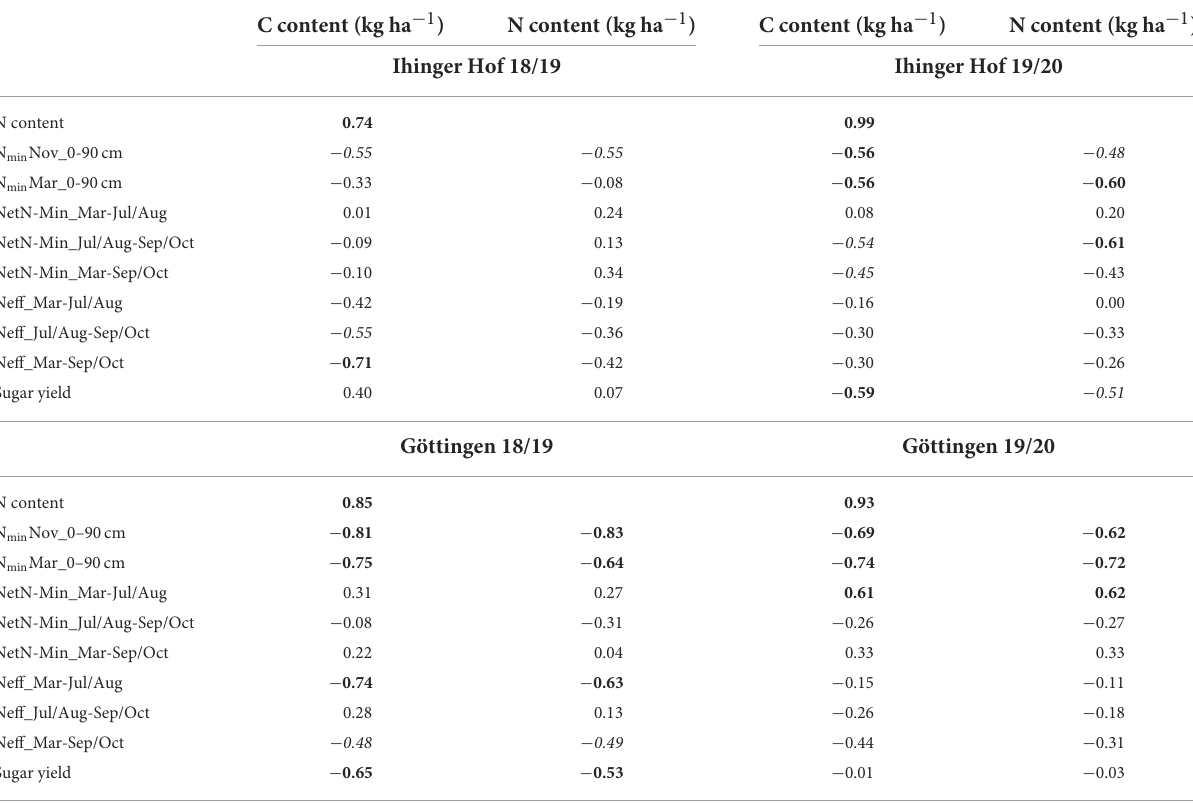
TABLE 4 Pearson correlation coefficients for the correlation among cover crop C and N content and soil N min , net N mineralization under following unfertilized sugar beet (NetN-Min) and the cover crop N effect on sugar beet (N eff ) for different dates/periods, and autumn sugar yield at Ihinger Hof 2018/19 and 2019/20, and Göttingen 2018/19 and